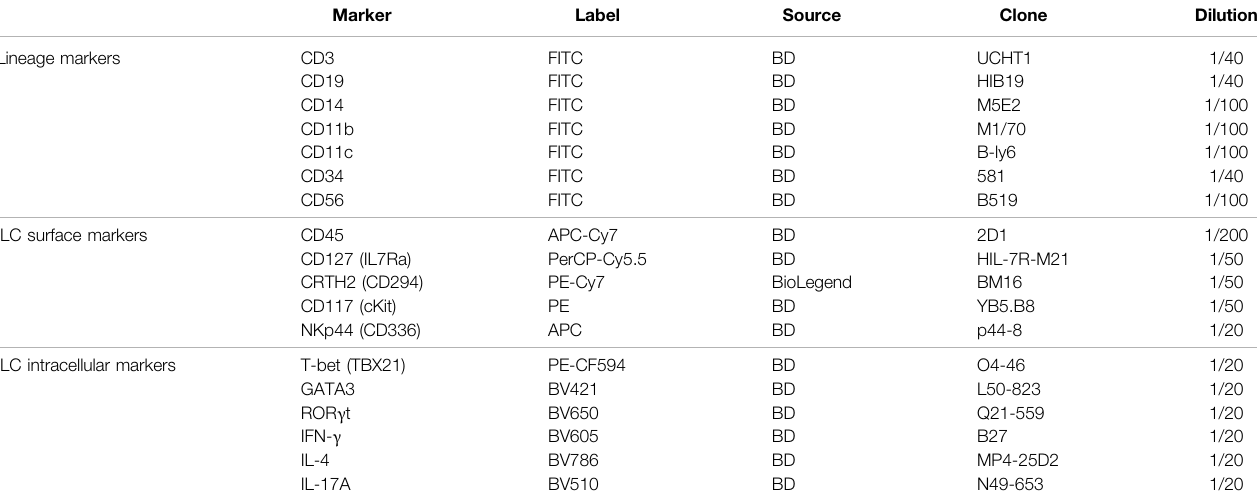
TABLE 2 | Description of the antibodies used to de fi ne